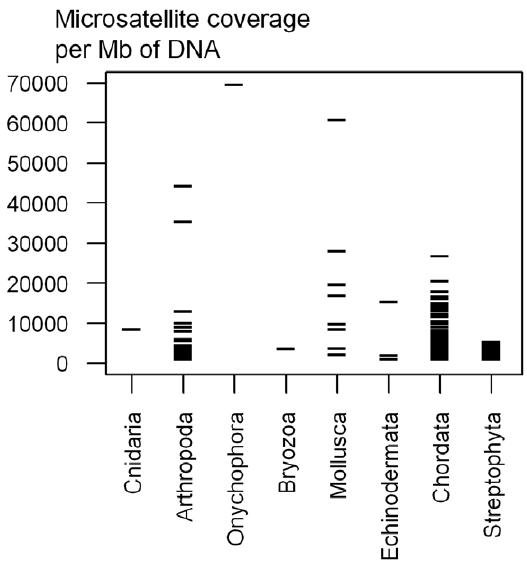
Figure 4. Microsatellite coverage by phyla. Microsatellite cover- age is the number of bases of microsatellites (di-hexanucleotide motifs) per Mb of DNA.